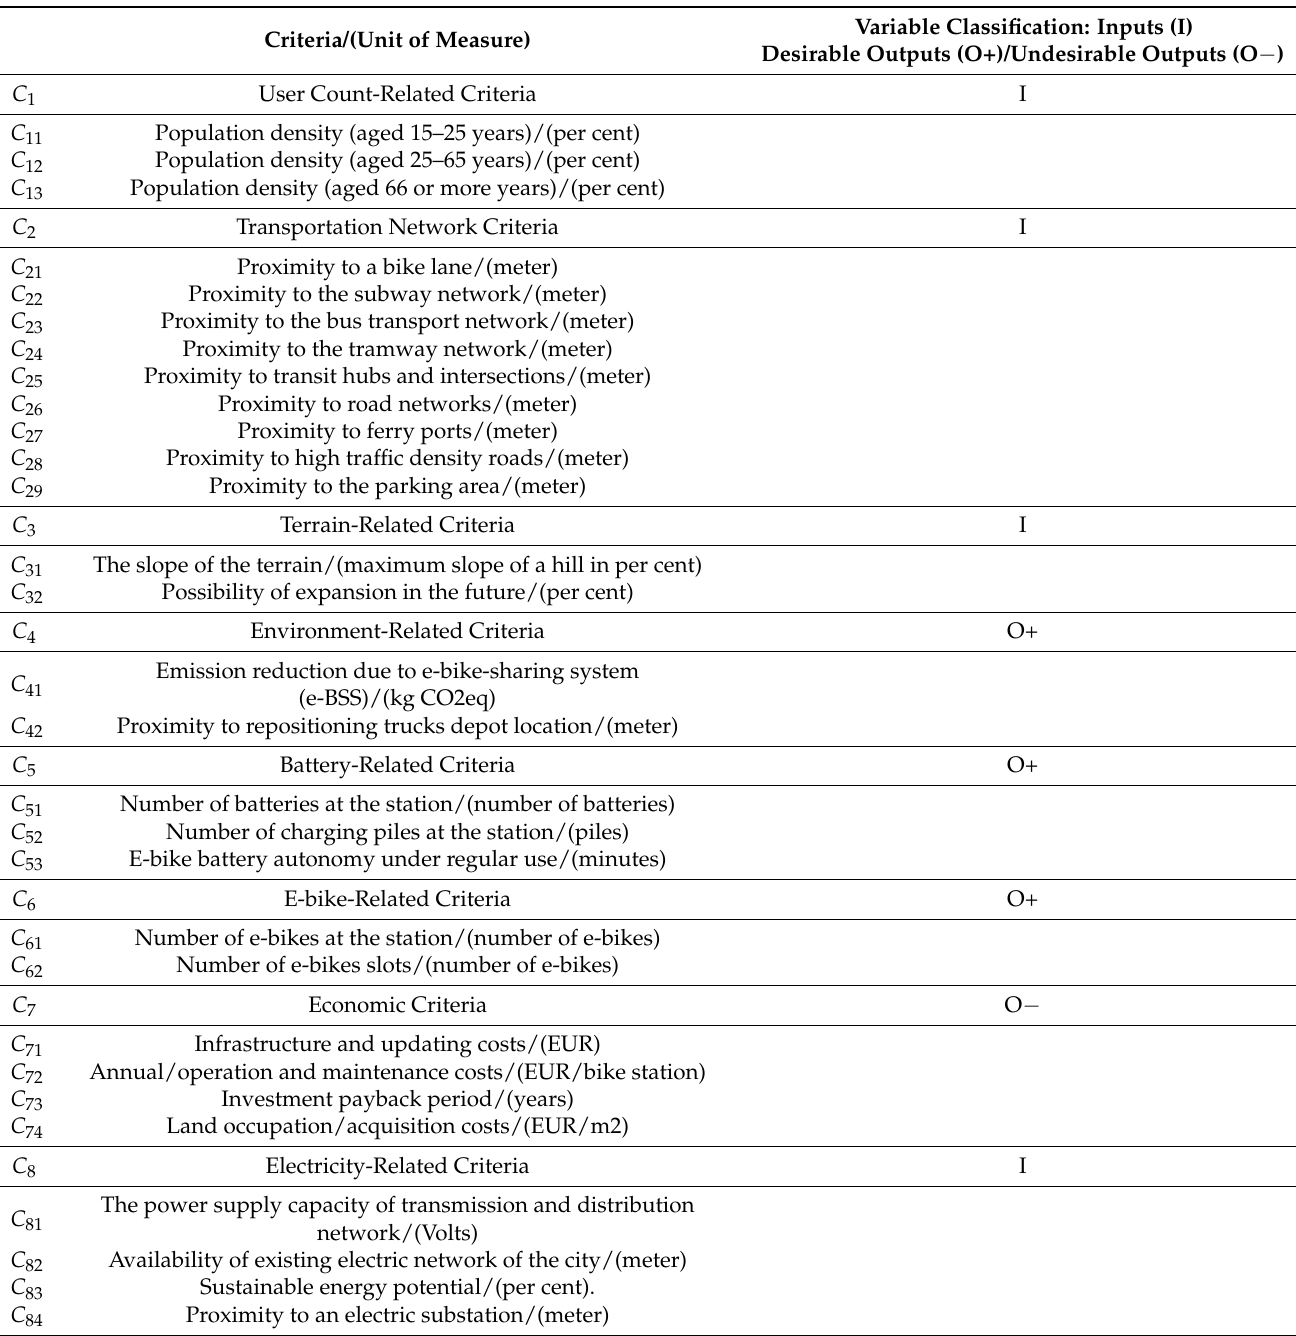
Table 1. Criteria structure and variable definition in the DEA